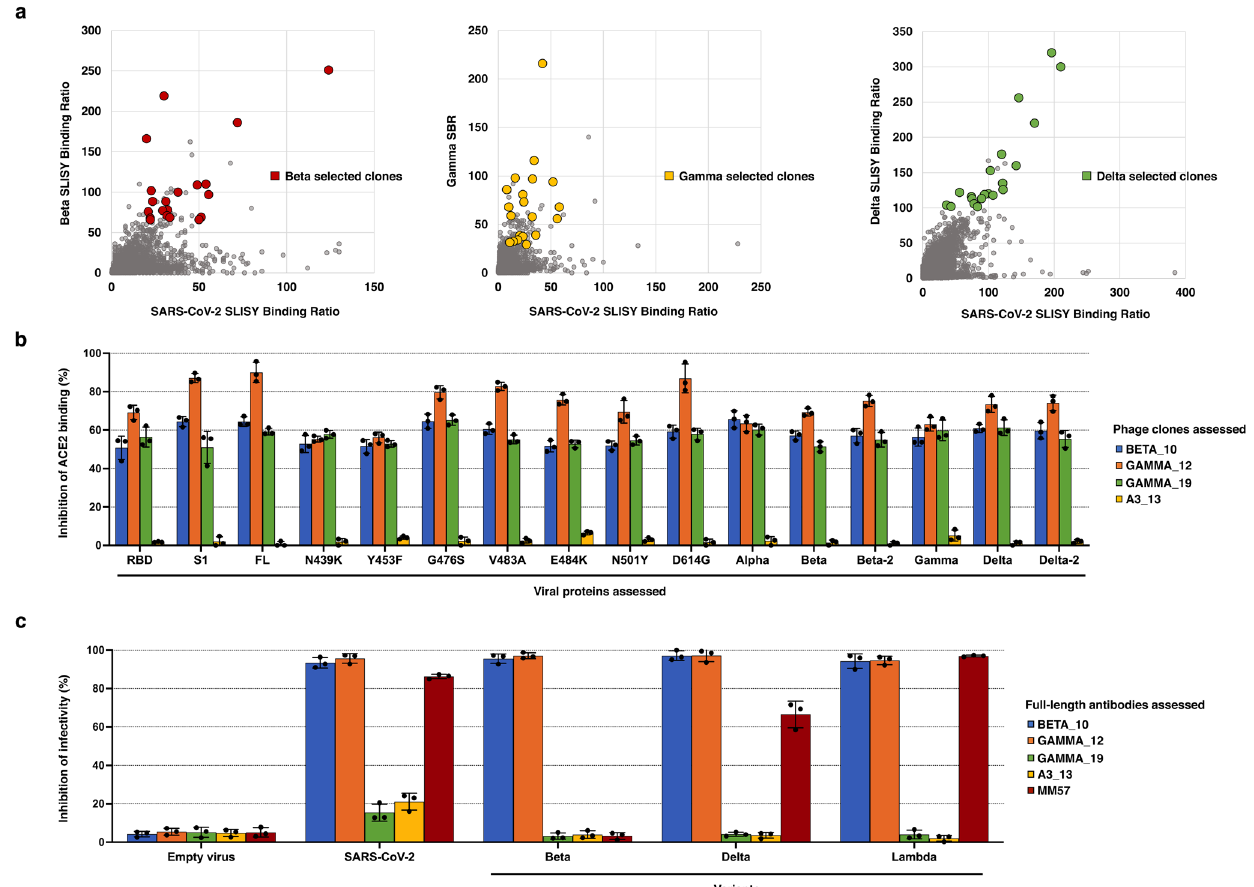
Fig. 6 | Using SLISY to identify clones that binding across multiple variants. a Selecting variant binding clones for validation. After applying the enriched pool of scFvs from biopanning with the original SARS-CoV-2 to variant proteins, the original SARS-CoV-2 SBR for each clone was plotted against a variant SBR. Clones were selected for testing based on high SBRs for both the original and variants. Twenty clones were selected from each of the original-variant pairings. b Broad spectrum neutralization by superclone scFvs Beta_10, Gamma_12, and Gamma_19. The full-length scFv phage clones were applied to wells pre-coated with variant